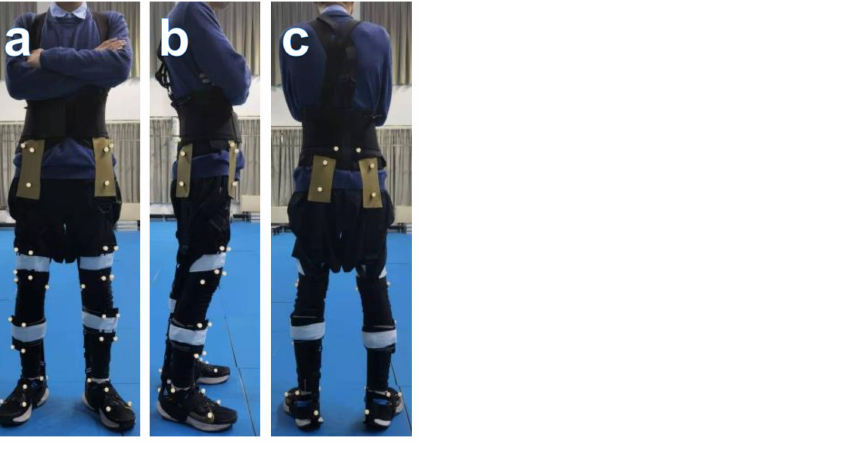
Figure 5. ( a ) Front, ( b ) side and ( c ) rear of a participant and the placement of